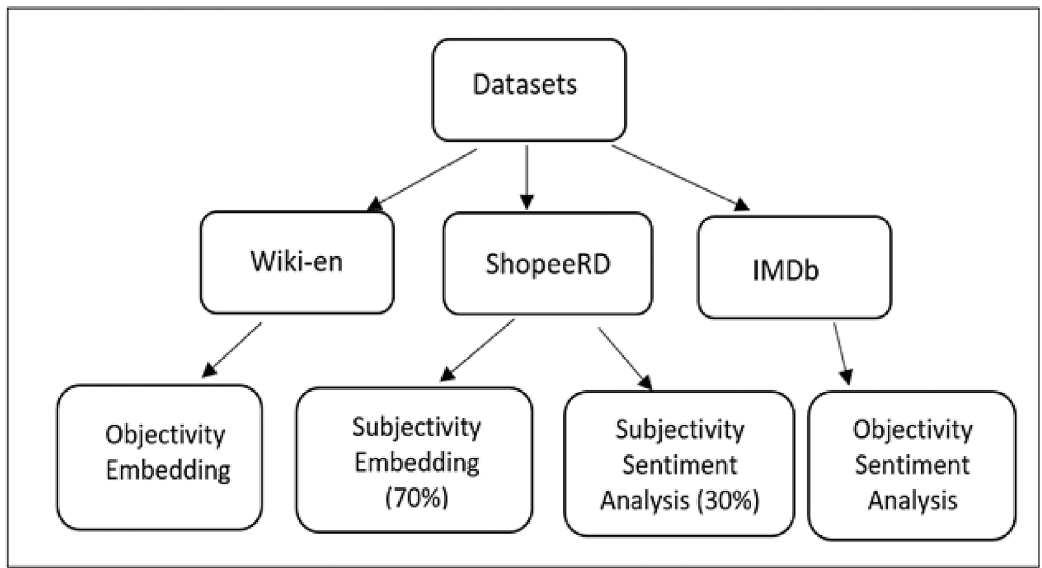
Figure 1. The mapping of